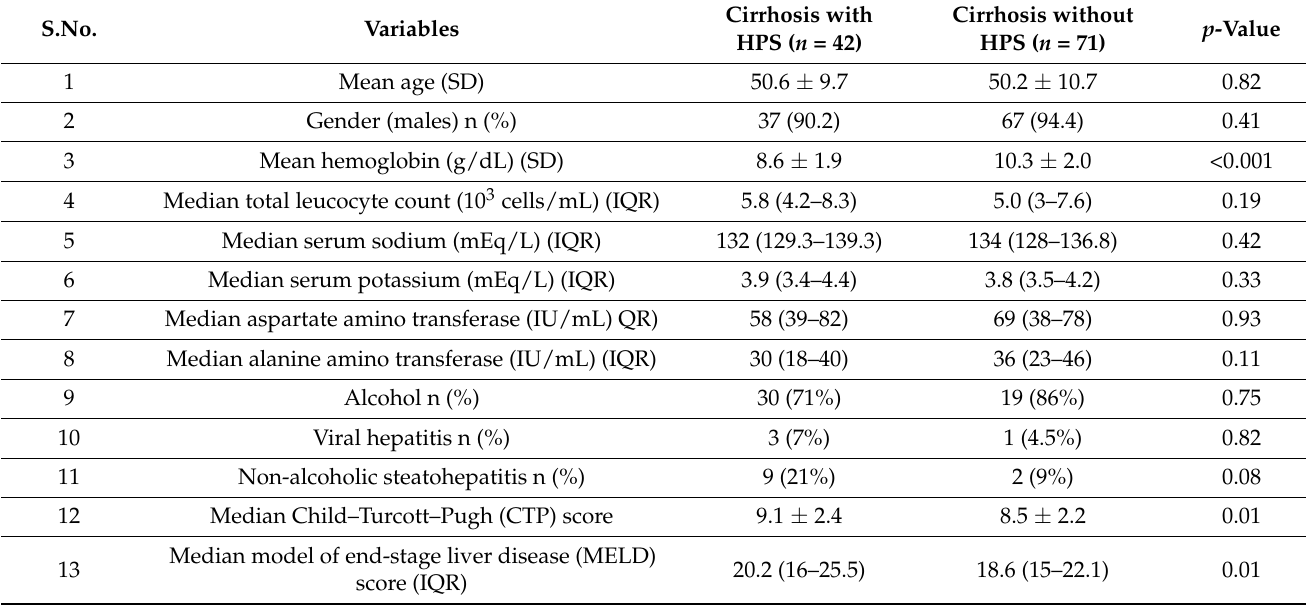
Table 1. Clinical characteristics of patients with and without hepatopulmonary syndrome in cirrho- sis